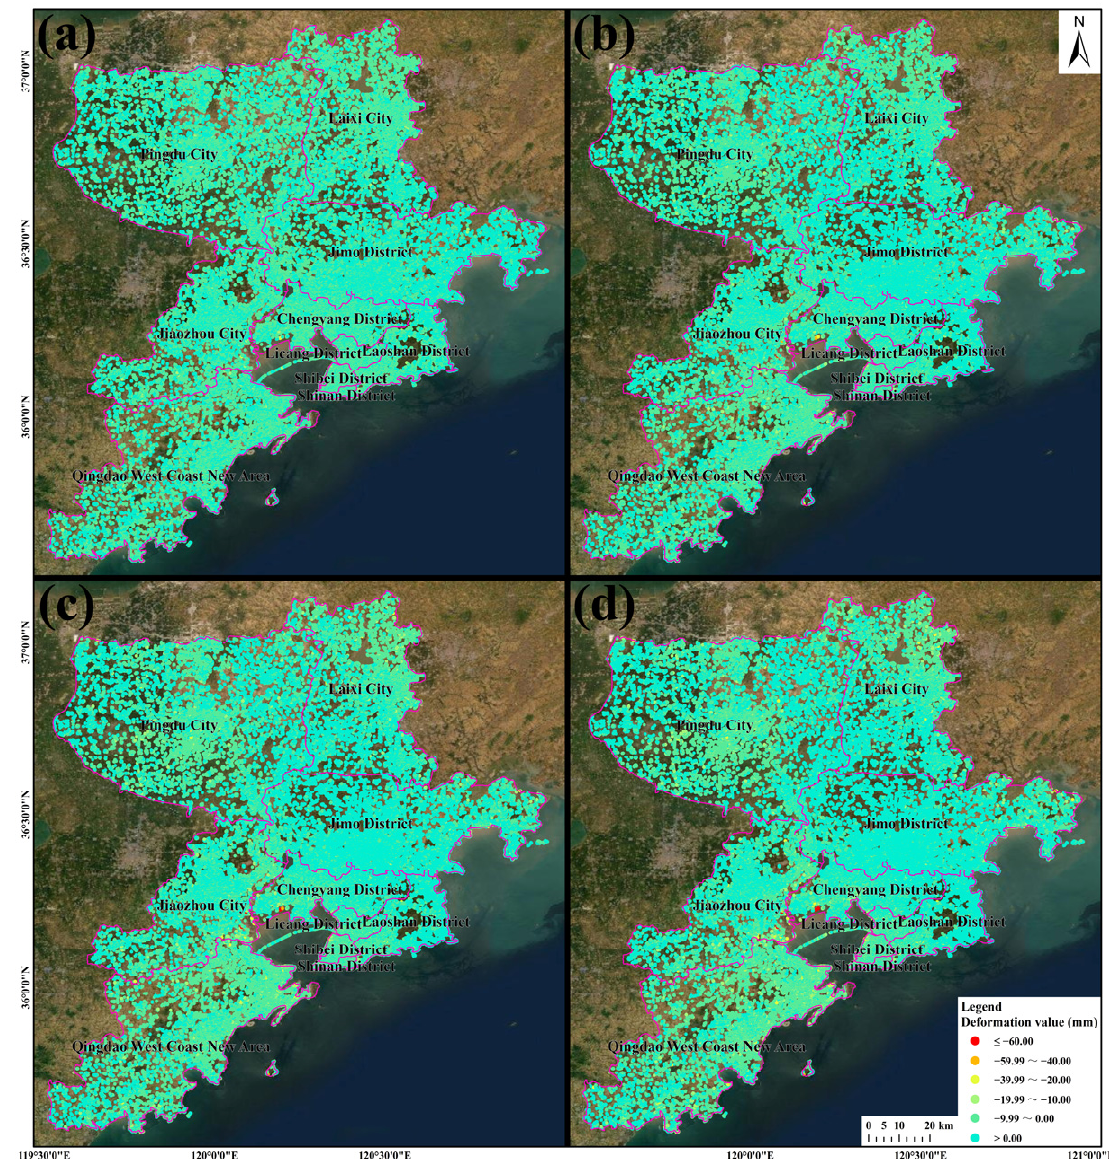
Figure 4. Annual variation in the land cumulative deformation in Qingdao: ( a ) April–December